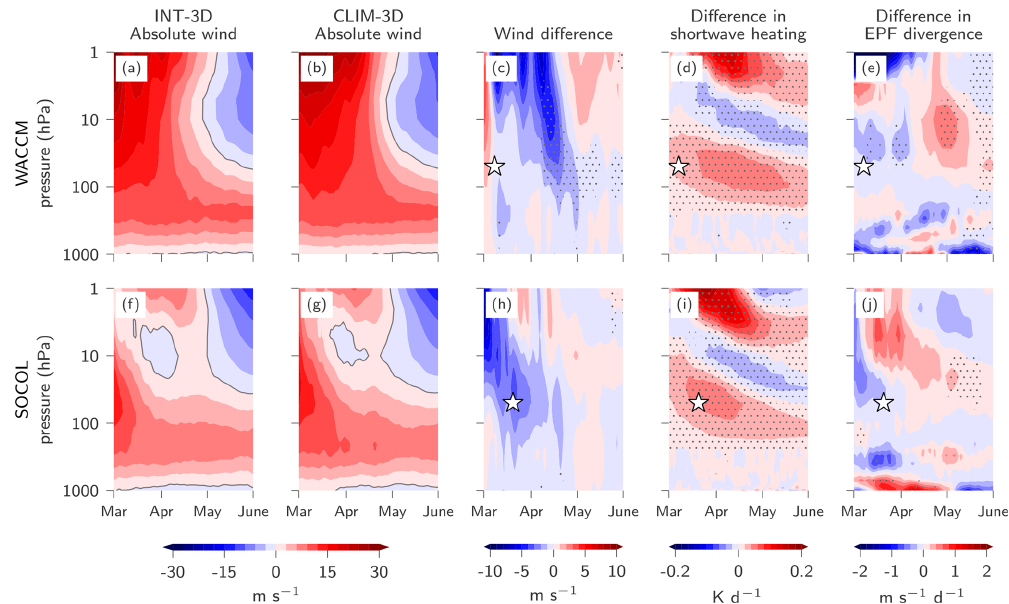
Figure 8. The impact of ozone anomalies on zonal wind and wave breaking in high-ozone springs. WACCM (top row) and SOCOL-MPIOM (bottom row) 55–75 ◦ N zonal mean zonal wind in high-ozone springs in INT-3D (first column) and CLIM-3D (second column) and zonal mean zonal wind in INT-3D minus CLIM-3D (third column). Differences in shortwave heating anomalies between INT-3D and CLIM- 3D (d, i) and differences in EPF divergence between INT-3D and CLIM-3D (30d running mean, right column). The ozone maximum date is marked by a star. Stippling shows regions where differences between INT-3D and CLIM-3D are significant on a 4.6% level.